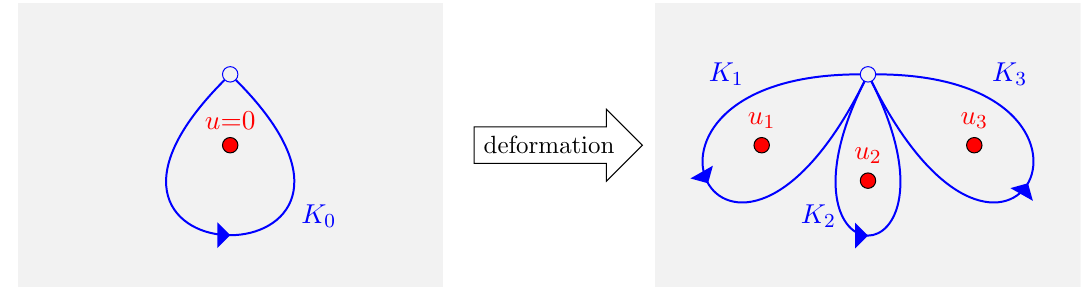
Figure 4 . Singularities and their monodromies on the CB before and after a relevant deformation. (This is a \top down" view of (cid:12)gure 1.) The solid points with coordinates u a are the singularities. The K a SL(2 ; Z ) are EM duality monodromies associated to the closed paths looping around 2 these singularities, and satisfy K 0 = K 3 K 2 K 1